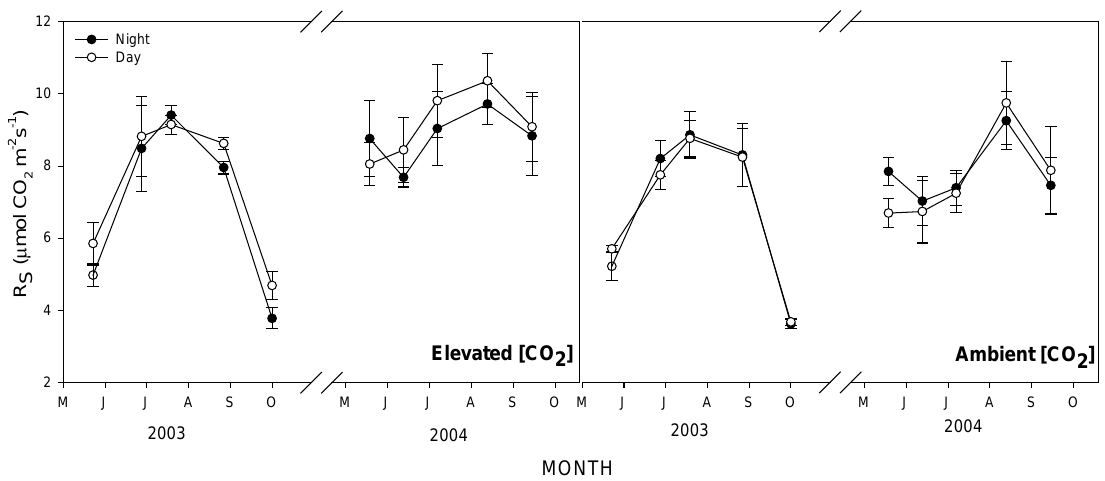
Fig. 1. The rates of soil respiration at FACTS-1 under ambient and elevated [CO 2 ] during the growing seasons of 2003 and 2004 and measured at night (filled symbols) and daytime (open symbols). Values are means ± standard error ( n = 3).